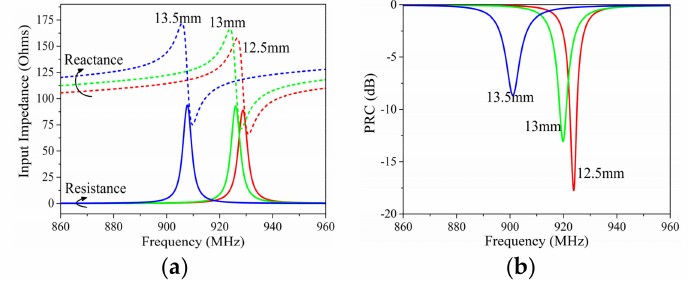
Figure 6. Simulated ( a ) input impedance and ( b ) PRC results with di ff erent lengths of Rf .